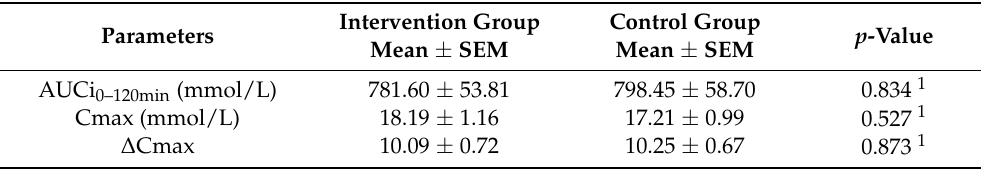
Table 4. Mean values of blood glucose incremental area under the curve (AUCi), glucose maximum concentration (Cmax) and variation of glucose maximum concentration ( ∆ Cmax) of study participants for intervention ( n = 18) and control ( n = 18) group.